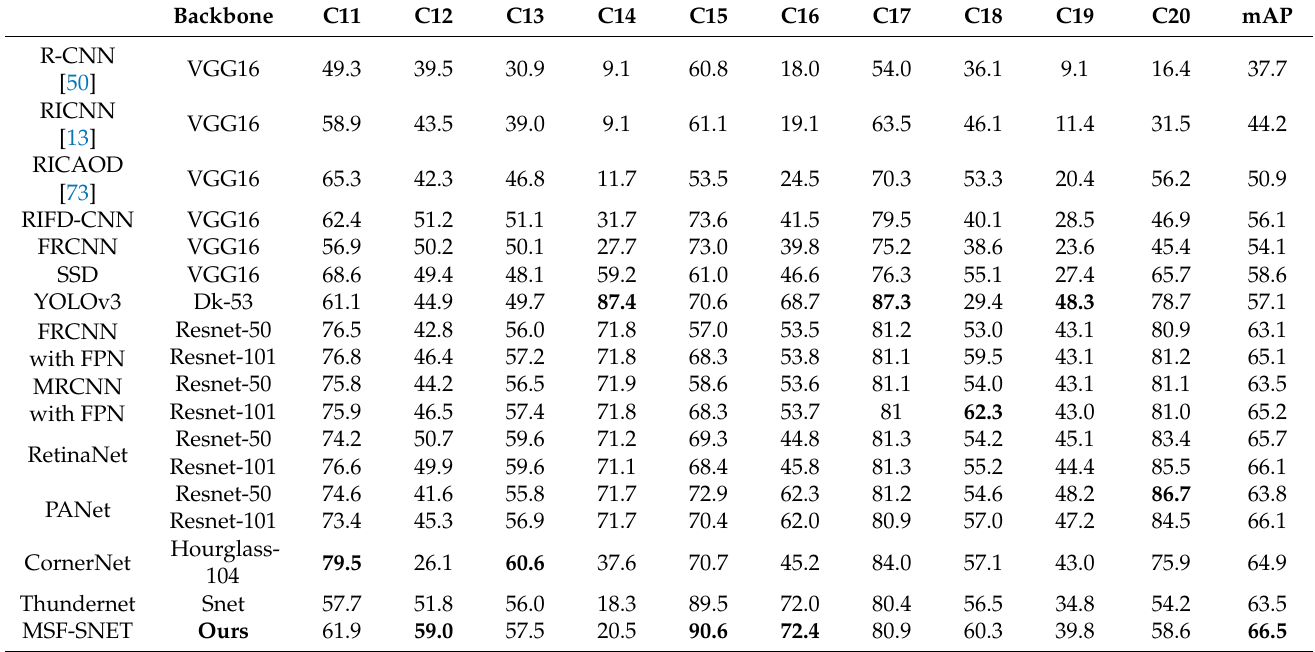
Table 6. Detection AP (%) comparison of different algorithms on DIOR dataset